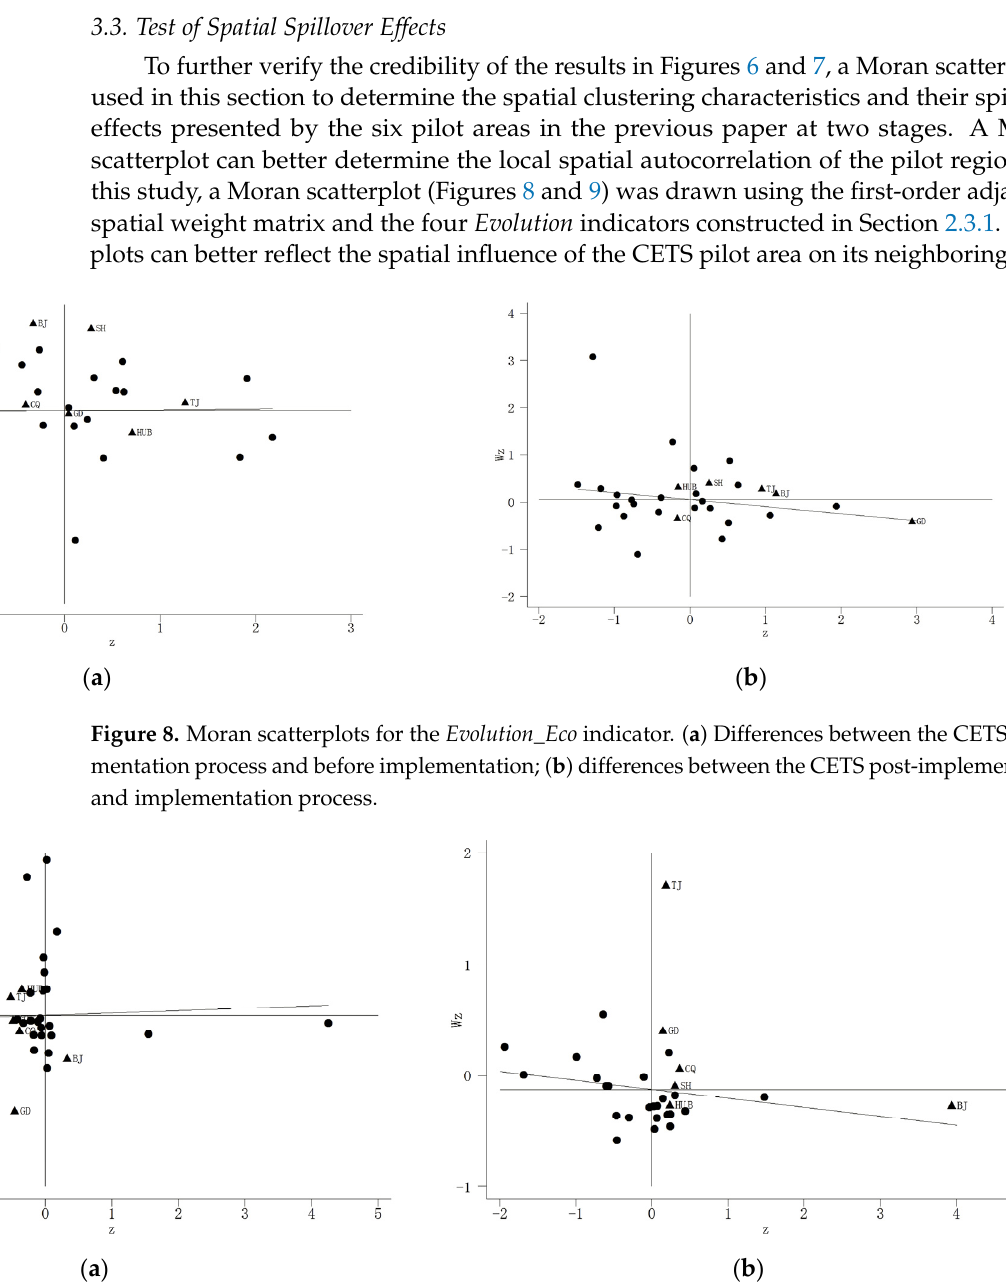
Figure 9. Moran scatterplots for the Evolution_Env indicator. ( a ) Differences between the CETS im- plementation process and before implementation; ( b ) differences between the CETS post-implementation and implementation